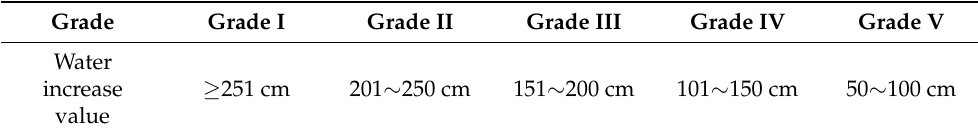
Table 1. Storm water increase grade standard